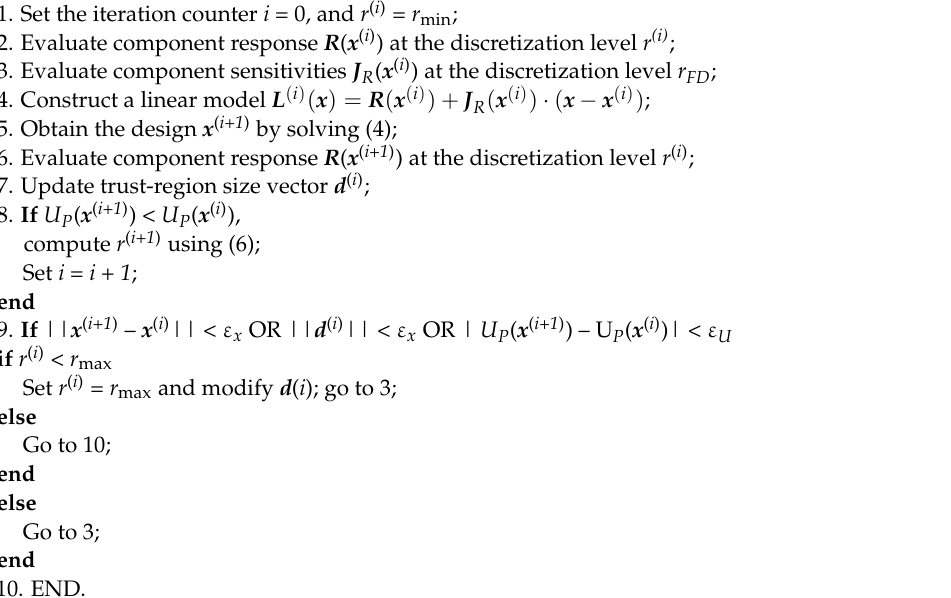
Algorithm 1. The algorithm exploits two main components: the trust region algorithm of Section 2.2 and the multi-fidelity model arrangement formulated in Section 2.3. The algorithm control parameters are gathered in Table 1. Algorithm 1: Operation of the proposed multi-fidelity size reduction